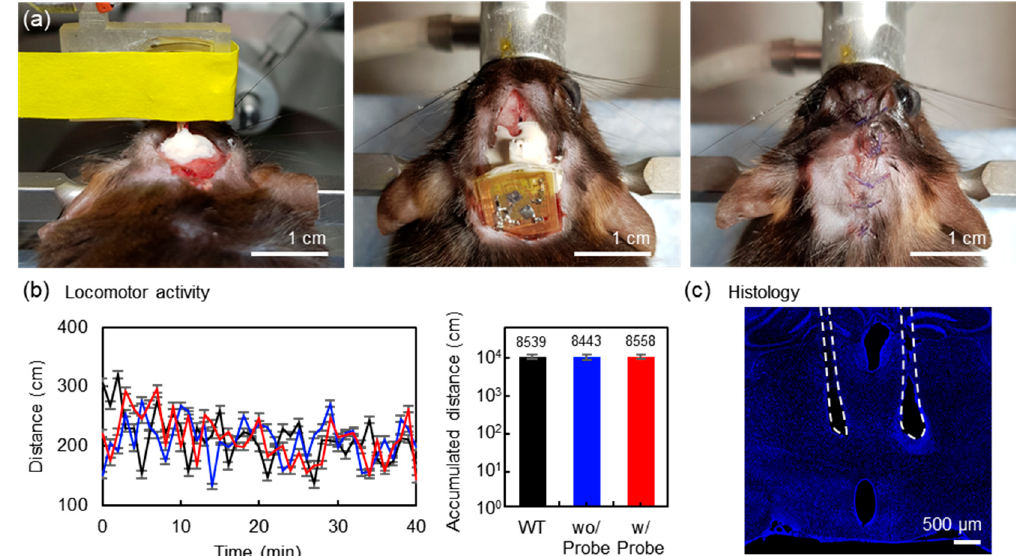
Figure 5. Surgical procedures for implanting the device for operation in the deep brain and locomotor activity. ( a ) Images of the surgical steps for holding, positioning, and injecting the body of the device. ( b ) Comparisons of the locomotor activity of the implanted device with probes (Red; n = 4), that of wild type mice (non-surgery; Black; n = 4), and that of the implanted device without probes (Blue; n = 4). The y-axis of the bar graph (Right) is a logarithmic scale. ( c ) Histology of a mouse brain with the device implanted. Dotted lines represent the placement of probes in the brain.